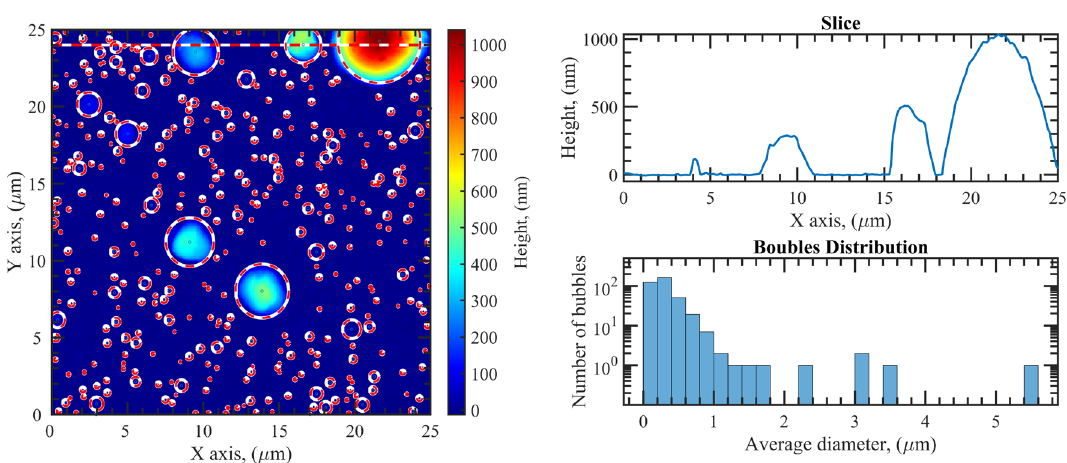
Figure 8. AFM image of the sample irradiated with 100 keV He ions (on the left). On the right: a height profile for the evaluation of the bubble sizes and the bubble count as function of their